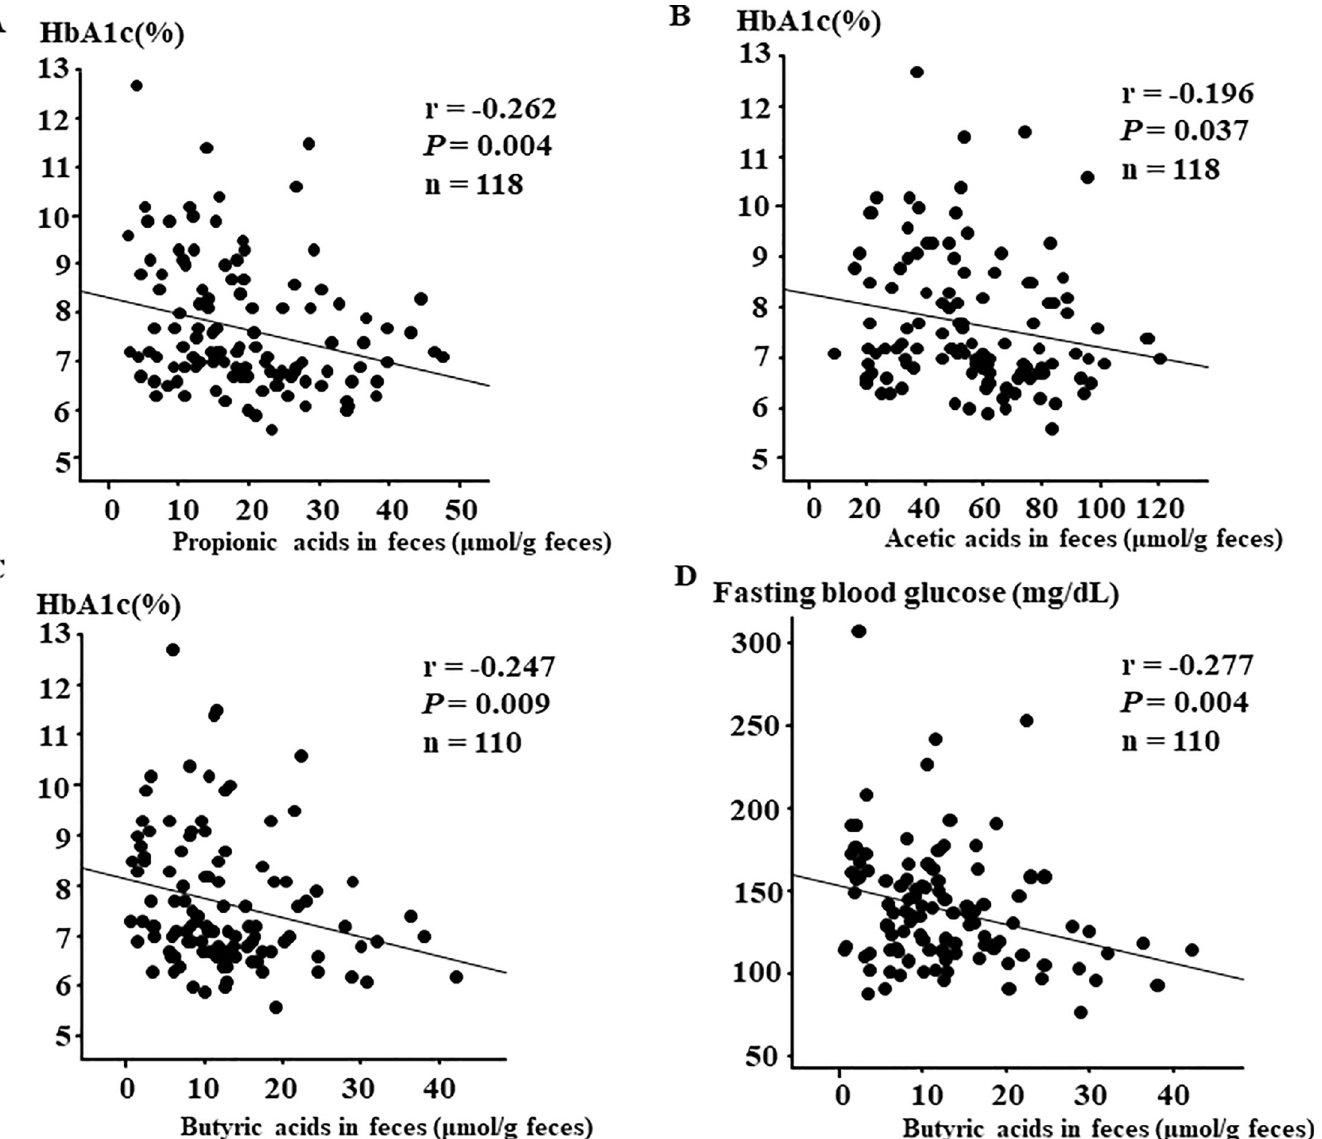
Fig 3. Correlations between glycemic control and organic acids in feces. Correlation between (A) HbA1c and propionic acids in feces (r = -0.262, P = 0.004, n = 118), (B) HbA1c and acetic acids in feces (r = -0.196, P = 0.037, n = 118), (C) HbA1c and butyric acids in feces (r = -0.247, P = 0.009, n = 110) and (D) fasting blood glucose and butyric acids in feces (r = -0.277, P = 0.004, n = 110).